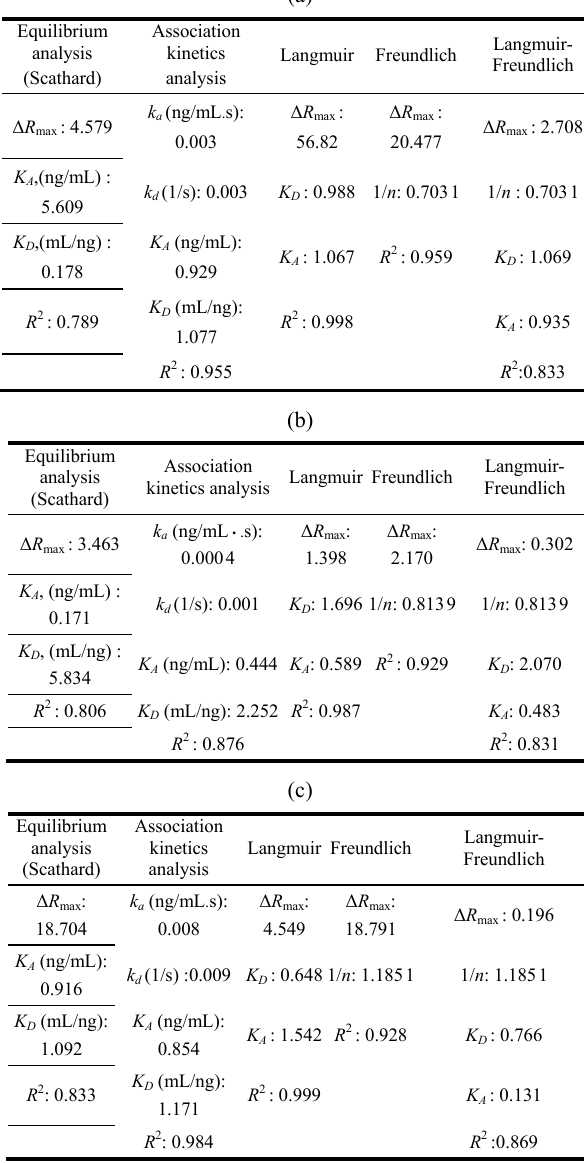
Table 1 Kinetic and isotherm parameters [(a) vitamin B2, (b) vitamin B9, and (c) vitamin B12 imprinted SPR sensors]. (a)